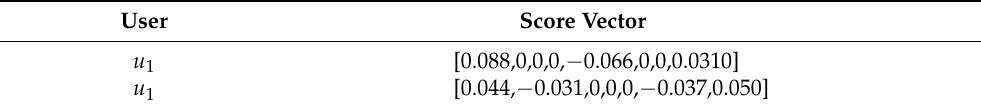
Table A2. Score in DeleteCandidate.